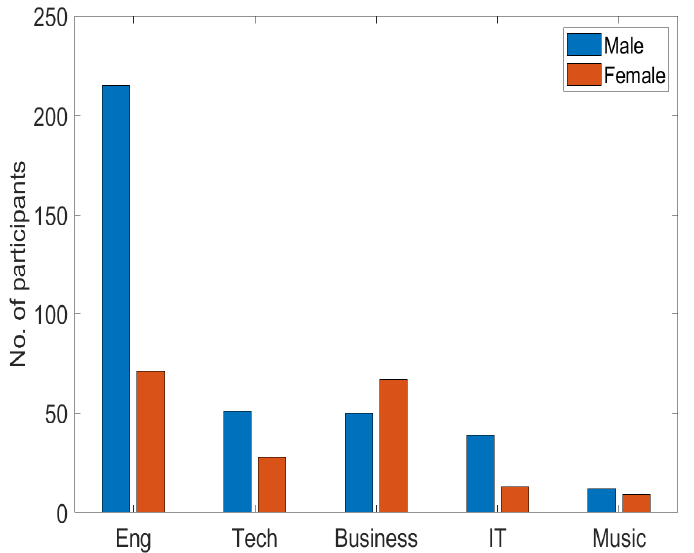
Figure 1. The distribution of participants among 5 different schools in the collected data sample. The survey results from each school were analysed for the devices used during the transition phase. The results also present an analysis of device usage pattern by male and female students during the same